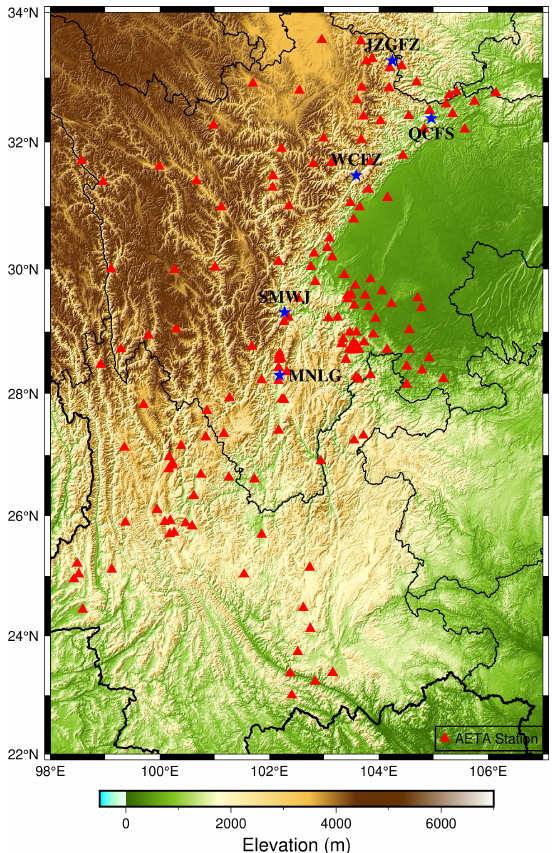
Figure 2. Distribution of AETA stations in Sichuan province in China. The stations used in next section are marked by blue stars, and positions of other stations marked by red